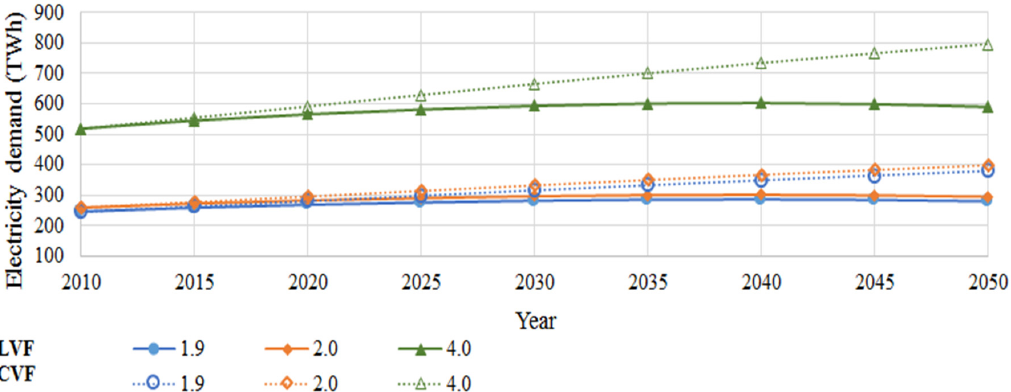
Figure 6. The analyzed electricity demand conditions determined with two population models and three demand conditions per capita. Prepared by the authors based on data from cited reference [19].